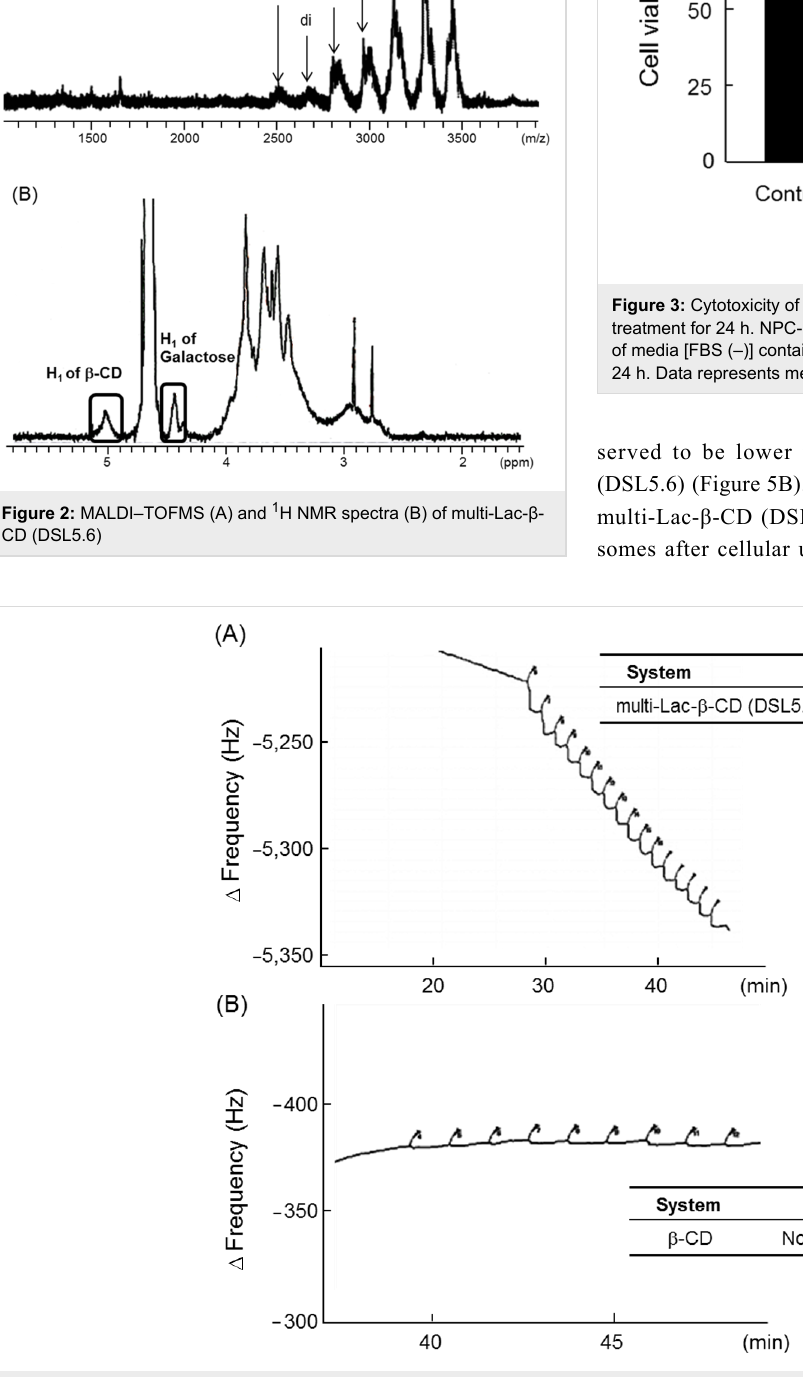
Figure 4: Binding curves of multi-Lac- β -CD (DSL5.6) (A) and β -CD (B) with peanut agglutinin (PNA). The binding curves for multi-Lac- β -CD (DSL5.6) and β -CD were determined by the quartz crystal microbalance (QCM) method. Phosphate-buffered saline (pH 7.4) was used as the sample buffer.